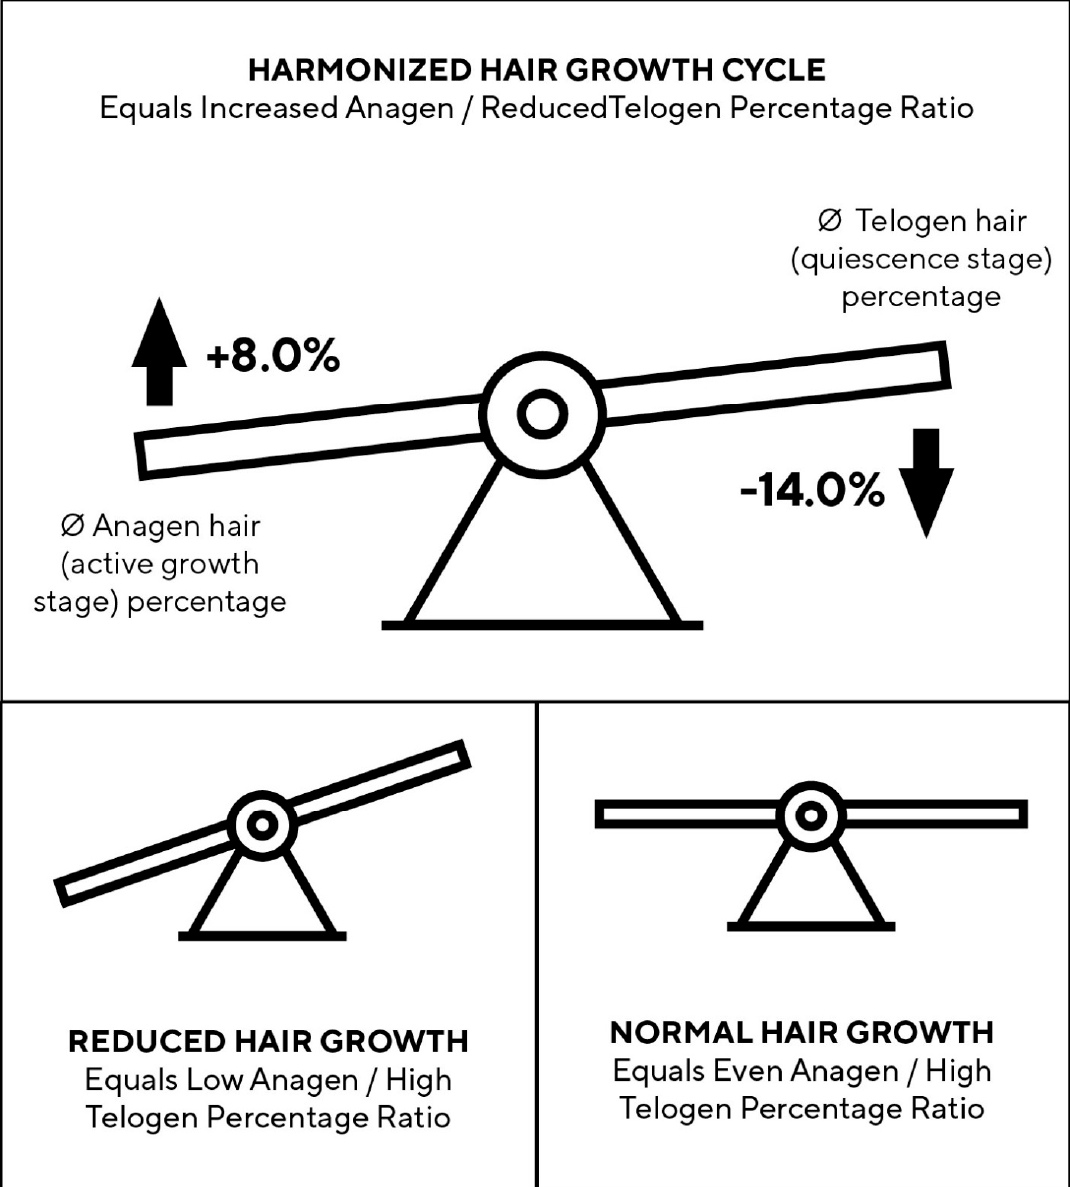
Figure 5. Tomorrowlabs [HSF] hair restoration harmonizes the hair growth cycle. The hair growth cycle was harmonized, with results of an average anagen hair percentage increase of +8.0% and telogen hair percentage reduction of − 14.0% shown in the test area after 9 months of treatment.